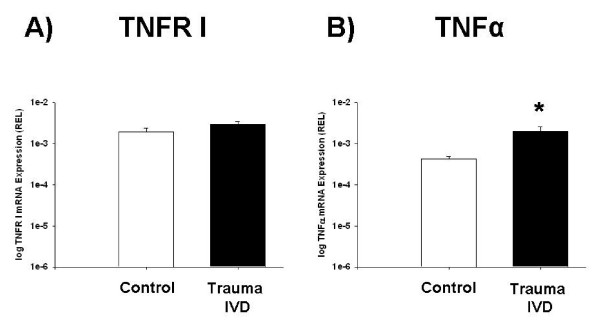
mRNA expression levels of the TNF receptor I (TNFR I) and TNFα in traumatic versus control IVD cells. A) TNFR I mRNA expression levels in traumatic IVD cells demonstrated increased values compared to control IVD cells. B) Analysis of the TNFα mRNA expression revealed significantly increased expression levels in traumatic IVD cells when compared to non-traumatic control IVD cells. * p < 0.05 as determined by Student's t test (trauma vs. control).